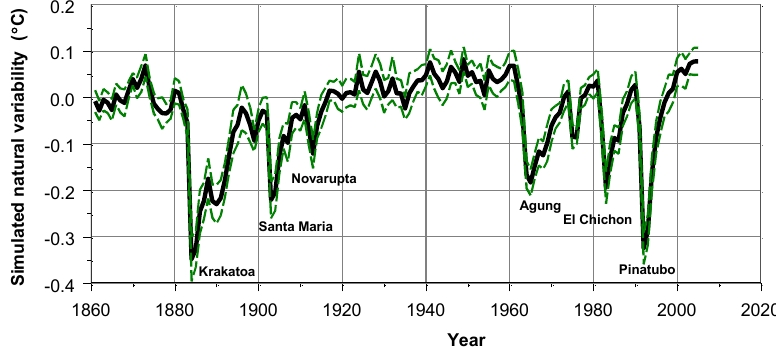
Figure 7. Natural variability based on 37 GCM simulations. Shown are mean values along with 2 standard errors. Period is